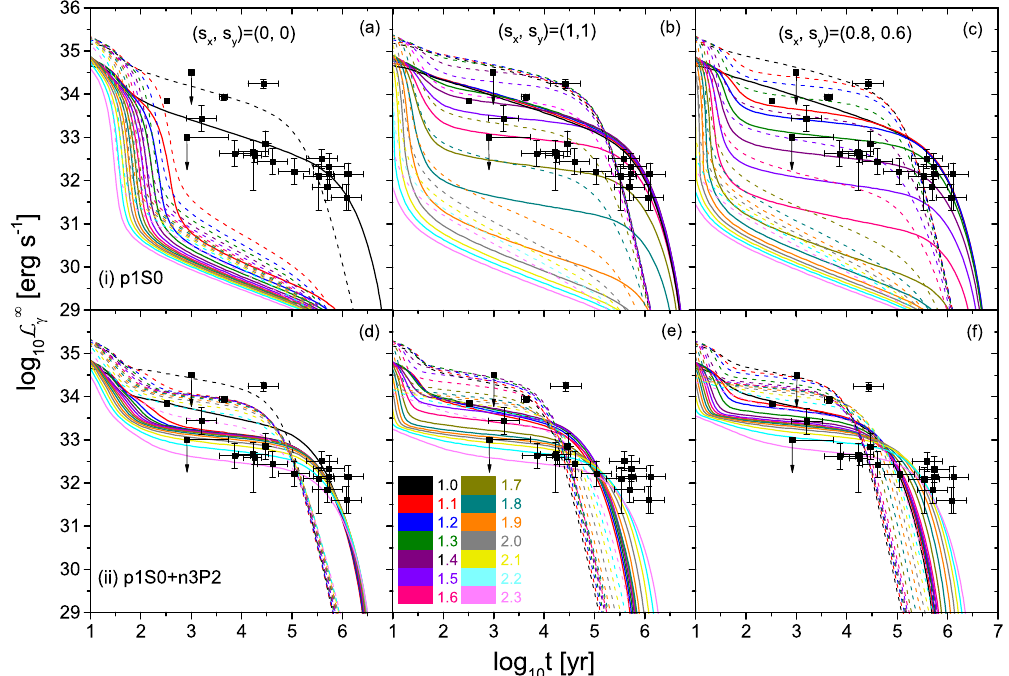
Figure 4. Cooling diagrams for p1S0 gap scaling factors ( s x , s y ) = ( 0,0 ) ; ( 1,1 ) ; ( 0.8,0.6 ) with (lower row) and without (upper row) n3P2 pairing, for different NS masses M / M (cid:12) = 1.0,1.1, . . . ,2.3 (decreasing curves). The solid curves are obtained with a Fe atmosphere and the dashed curves cover the same results obtained with a light-elements ( η = 10 − 7 ) atmosphere. The data points are from Reference [12]. See text for more